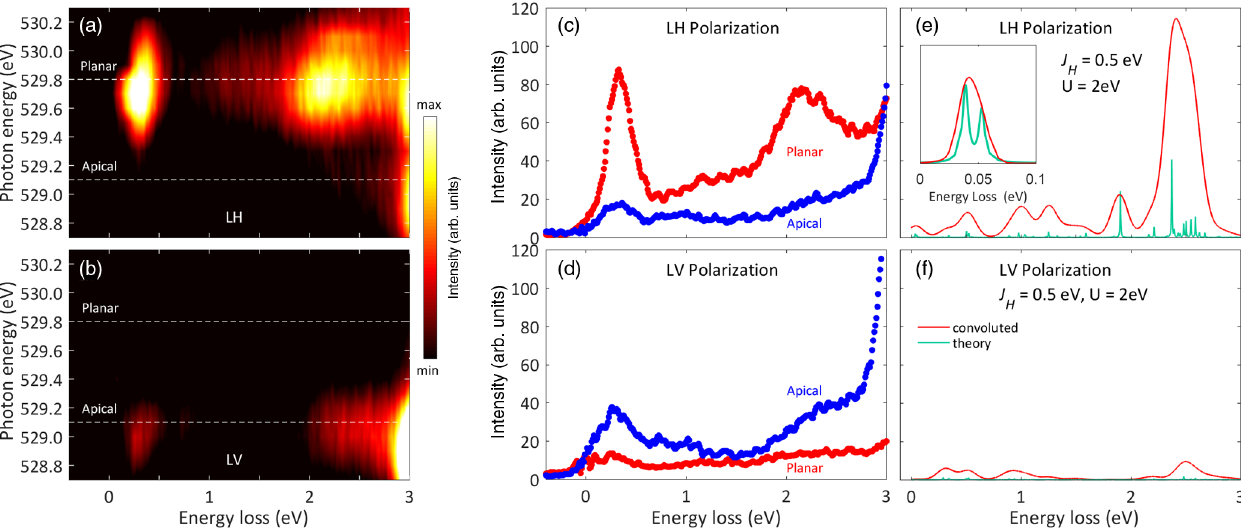
FIG. 3. Polarization dependence of the RIXS spectra versus incident photon energy. (a,b) RIXS response, in false intensity scale, as a function of energy loss and incident photon energy of LH and LV light polarization for the grazing incidence condition, as indicated. Horizontal dashed lines show the positions of the apical and planar resonances obtained from XAS. (c,d) RIXS spectra, with the elastic response subtracted, at the apical (blue lines) and planar (red lines) oxygen resonances for the respective light polarizations. (e,f) Calculated RIXS spectra for the planar site with respect to linear horizontal (c) and vertical (d) light polarization (see text for a detailed explanation of the model). Green lines indicate the expected excitations, and the solid red line is obtained by Gaussian convolution to mimic instrumental resolution. A standard deviation of σ ¼ 70 meV was applied in panels (e) and (f), whereas σ ¼ 7 meV was used for the inset, which displays a zoom on the lowest excitations at around 40